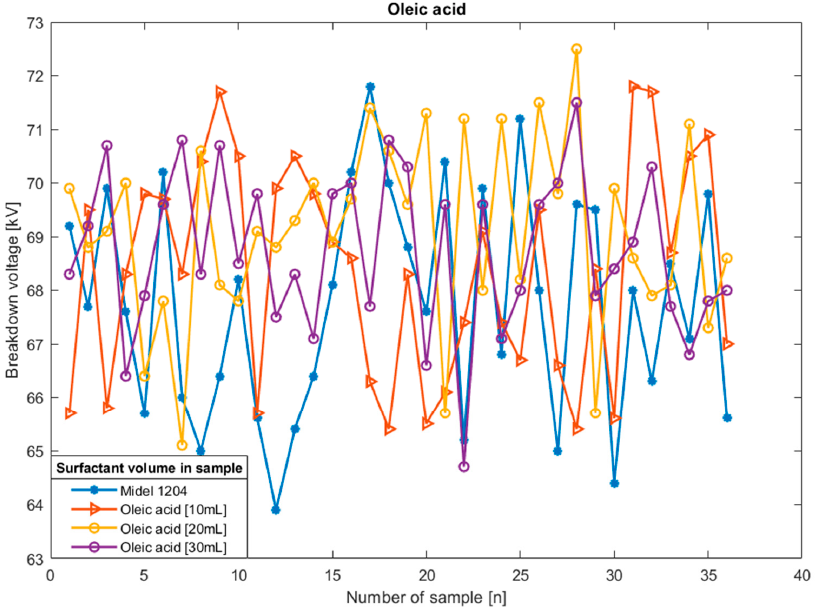
Figure 8. Breakdown voltage plot for oil sample Midel 1204 with different concentrations of surfactant oleic acid.